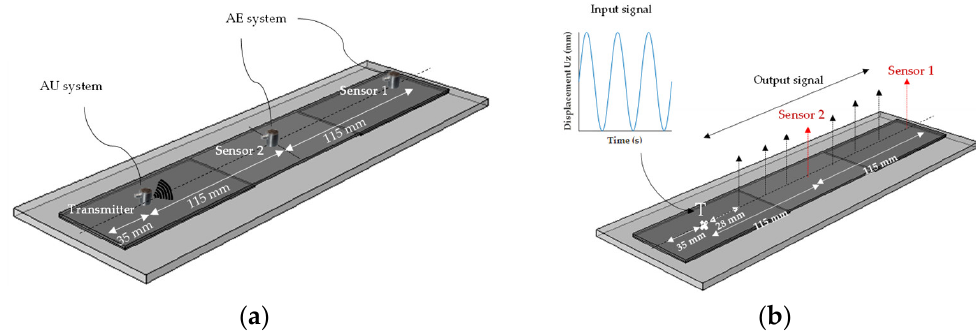
Figure 2. ( a ) Schematic representation of the composite/metal assemblies with the location of the defect and sensors (transmitter, sensor 2 and sensor 1 denote the positions of the transmitter and receivers during the tests). ( b ) Simulation of the AU test indicating the locations of the virtual transmitter and receiver sensors (T denotes transmitter), where each virtual receiver is separated by about 28 mm.